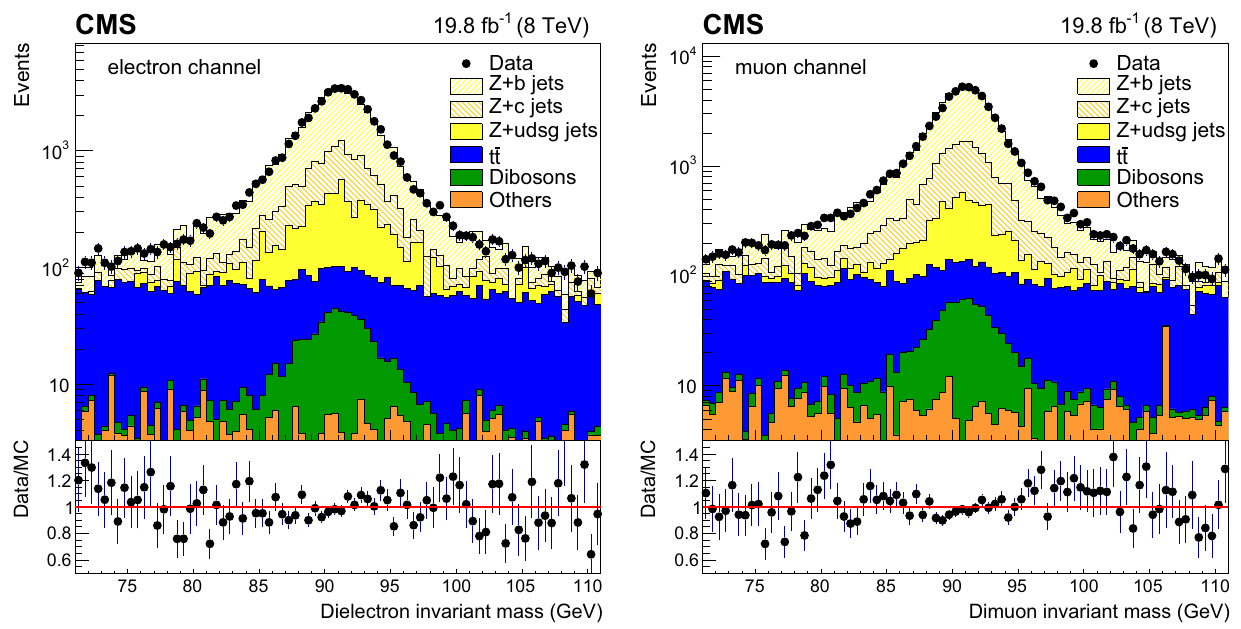
Fig. 2 Dilepton invariant mass distributions for Z ( 1b ) events, for the electron ( left ) and muon ( right ) Z boson decay channels. Error bars account for statistical uncertainties in data in the upper plots and in both data and simulation in the bottom ratio plots , that show the data to MC ratio